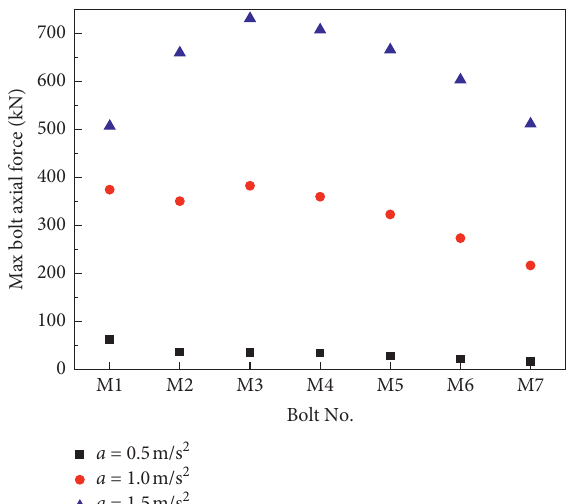
Figure 9: Maximum axial force of bolts at different